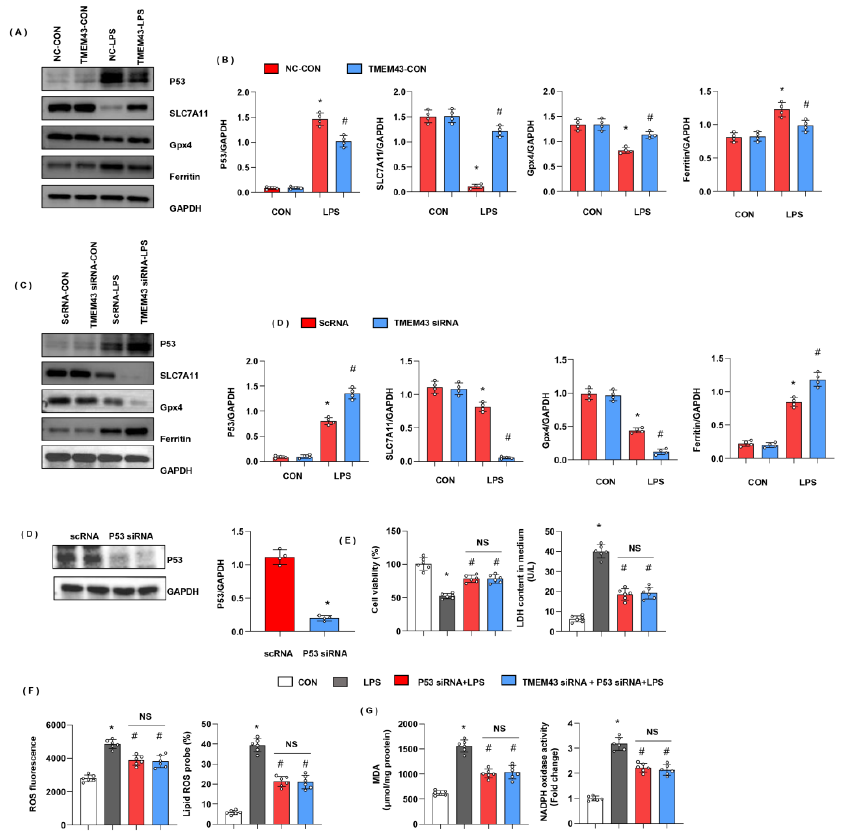
Figure 9. TMEM43 suppresses P53-mediated ferroptosis. ( A , B ) Protein level of P53, SLC7A11, Gpx4, ferritin in mouse hearts injected with AAV-TMEM43 under LPS challenge ( n = 4). * p < 0.05 vs. AAV-NC/CON group. # p < 0.05 vs. AAV-NC/LPS group. ( C , D ) Protein level of P53, SLC7A11, Gpx4, ferritin in H9c2 cells transfected with TMEM43 siRNA under LPS challenge ( n = 4). * p < 0.05 vs. scRNA/CON group. # p < 0.05 vs. scRNA/LPS group. ( E – G ) H9c2 cells were transfected with TMEM43 siRNA and P53 siRNA. ( E ) Cell viability and LDH level in H9c2 cells ( n = 6). ( F ) ROS level and lipid ROS level in H9c2 cells in each group ( n = 6). ( G ) MDA and NADPH oxidase activity in each group ( n = 6). * p < 0.05 vs. CON group. # p < 0.05 vs. LPS group.